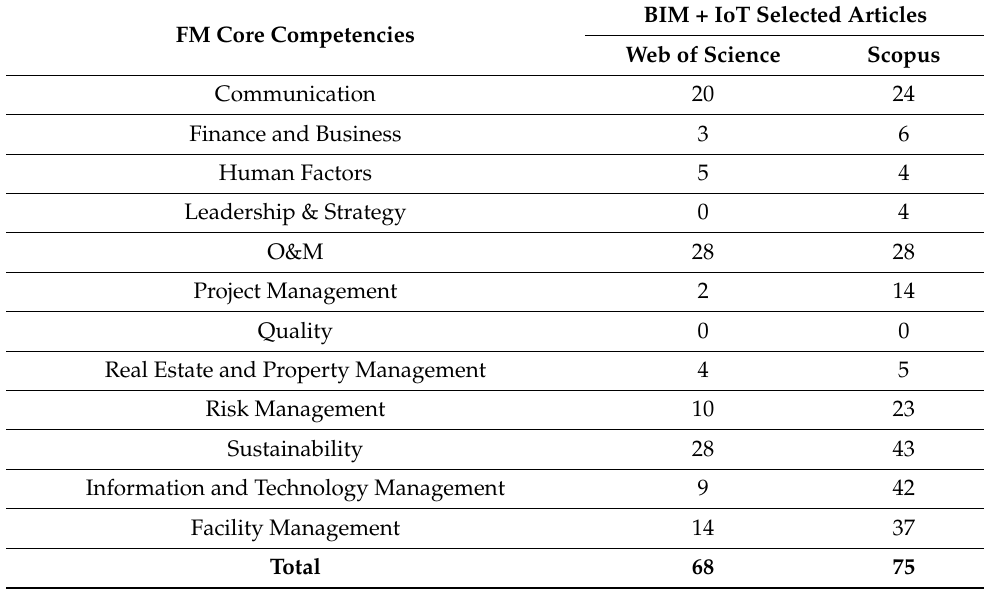
Table 5. Journals’ articles on BIM–IoT integration, for each FM core competence, from Web of Science and Scopus databases.